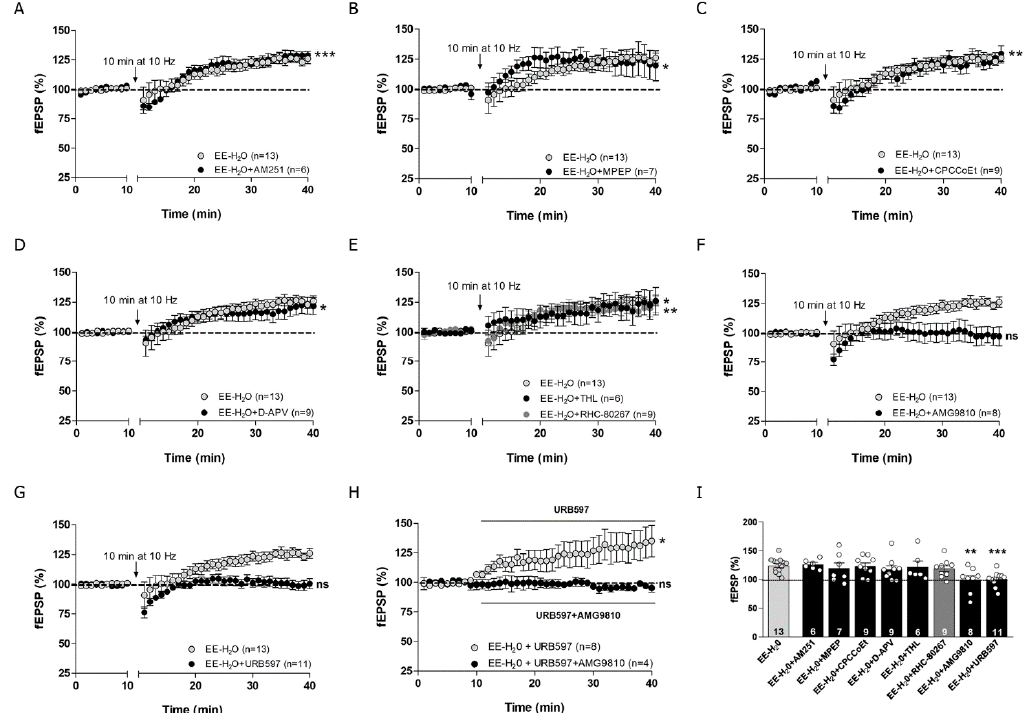
Figure 5. Activation of TRPV1 and AEA are required for MPP-LTP in EE-H 2 O. ( A ) AM251 (4 µ M, black circles; Student’s t -test; *** p ≤ 0.001 vs. baseline), ( B ) MPEP (10 µ M; black circles; Student’s t -test; * p ≤ 0.05 vs. baseline), ( C ) CPCCoEt (50 µ M; black circles; Student’s t -test; ** p ≤ 0.01 vs. baseline), ( D ) D-APV (50 µ M; black circles; Student’s t -test; * p ≤ 0.05 vs. baseline) and ( E ) THL (10 µ M; black circles; Student’s t -test * p ≤ 0.05 vs. baseline) and RHC-80267 (100 µ M; dark grey circles: Student’s t -test; ** p ≤ 0.01 vs. baseline) do not affect MPP-LTP in EE-H 2 O mice. ( F ) However, MPP-LTP is